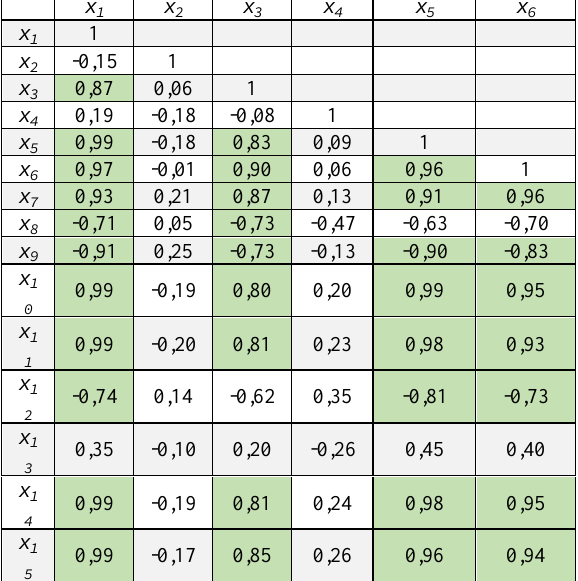
Table 2. Correlation coefficient (continuation)